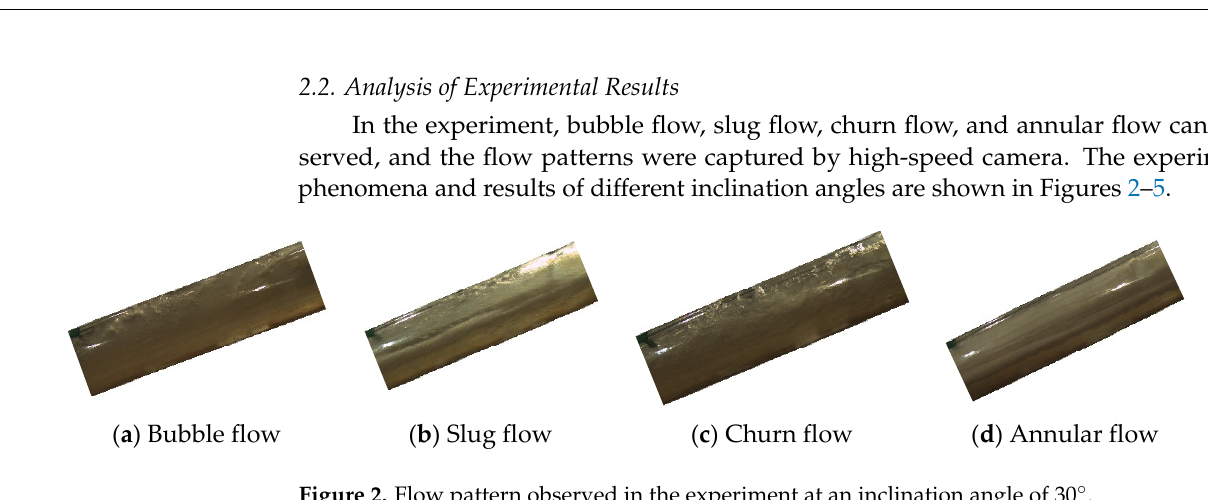
Table 1. Range of experimental parameters .